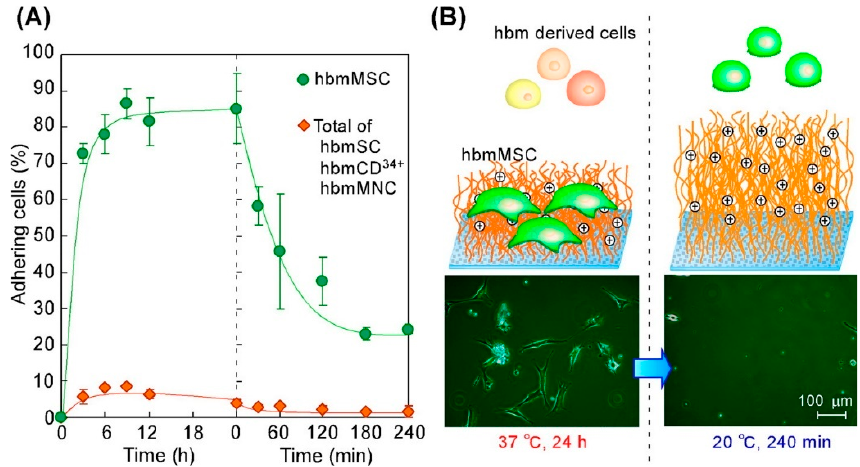
Figure 10. Adhesion and detachment profiles of human bone marrow mesenchymal stem cells (hbmMSC) and other human bone marrow-derived cells on poly( N IPAM- co - N , N -dimethylaminopropylacrylamide- co - N - tert -butylacrylamide) TRPBCs ( A ) and the mechanism of the separation of hbmMSC cells from other human bone marrow-derived cells (see text) ( B ) (with permission from [139]).